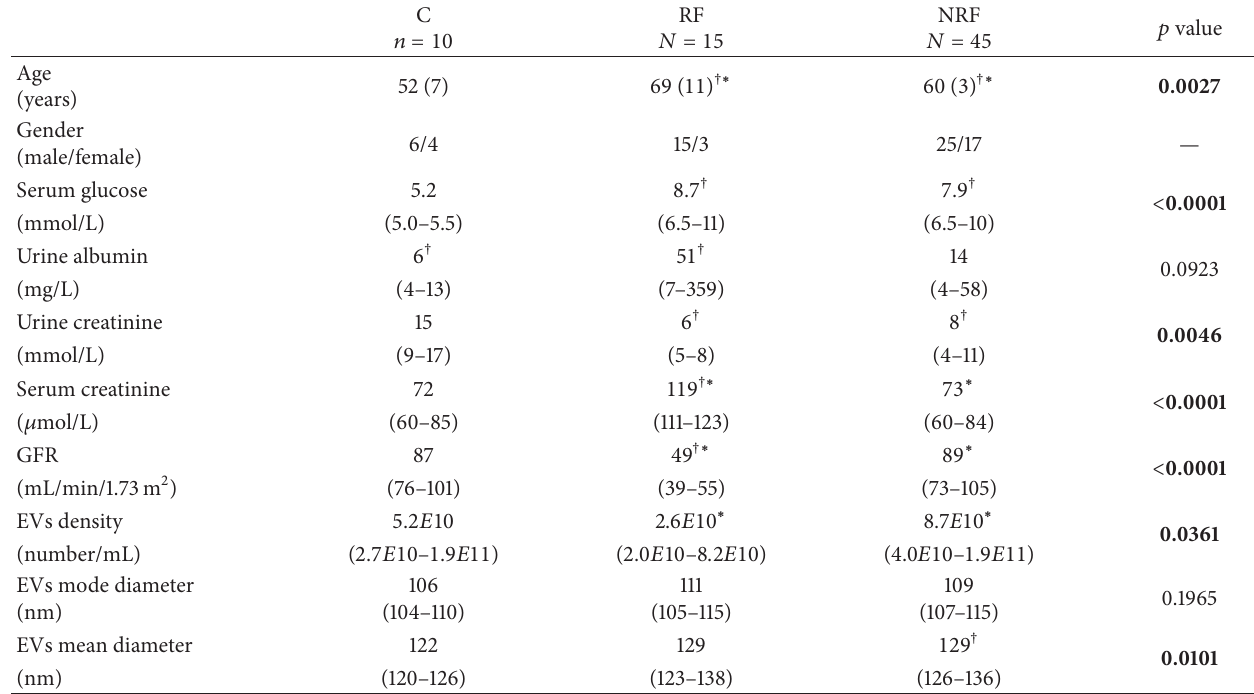
Table 2: Clinical characteristics, blood, and urine biochemistry of study groups: C, RF, and